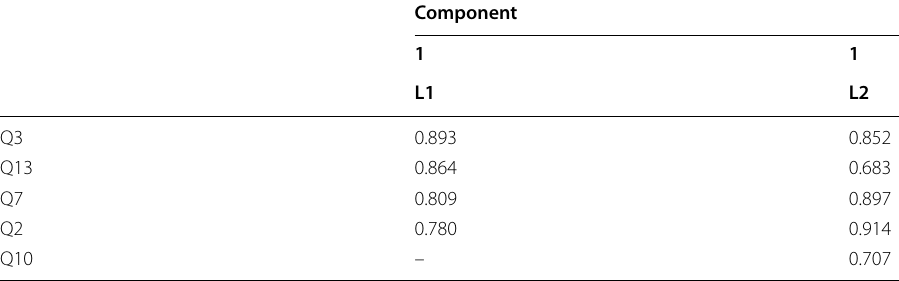
Table 7 Component matrix for L1 and L2 Use for Permission